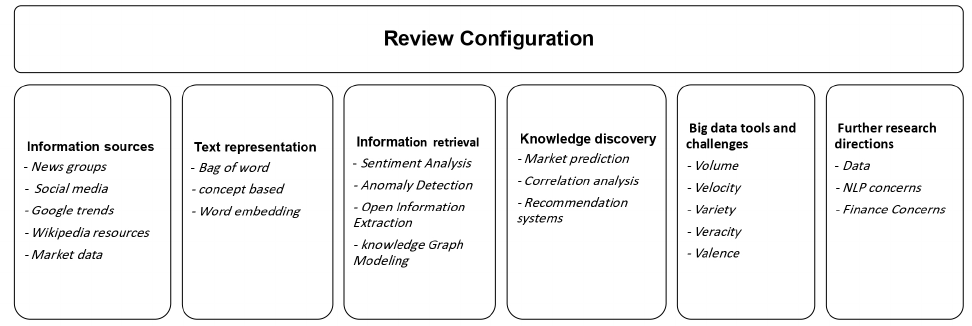
Figure 1. Organization of our review